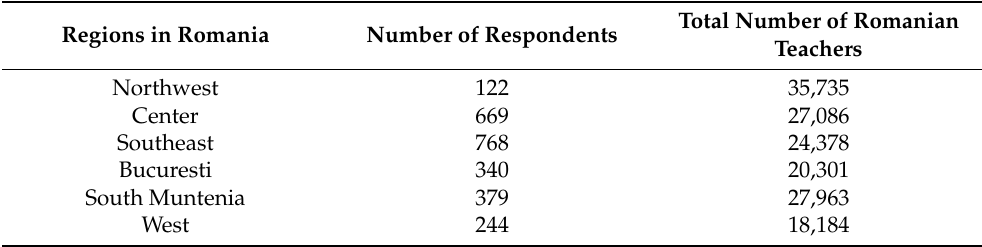
Table 2. The number of respondent teachers compared with the total number of teachers from the Romanian education system [50].